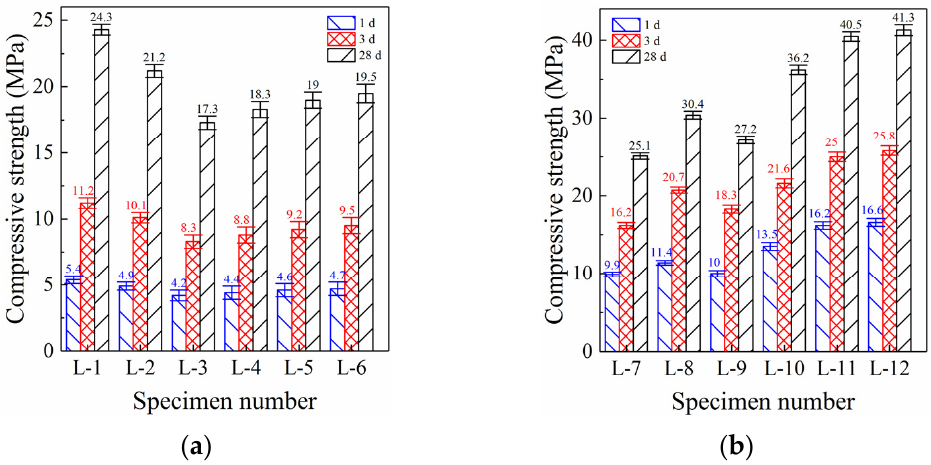
Figure 1. Development trend of compressive strength. ( a ) Portland cement grouting specimens. ( b ) GBFS alkali-activated grouting